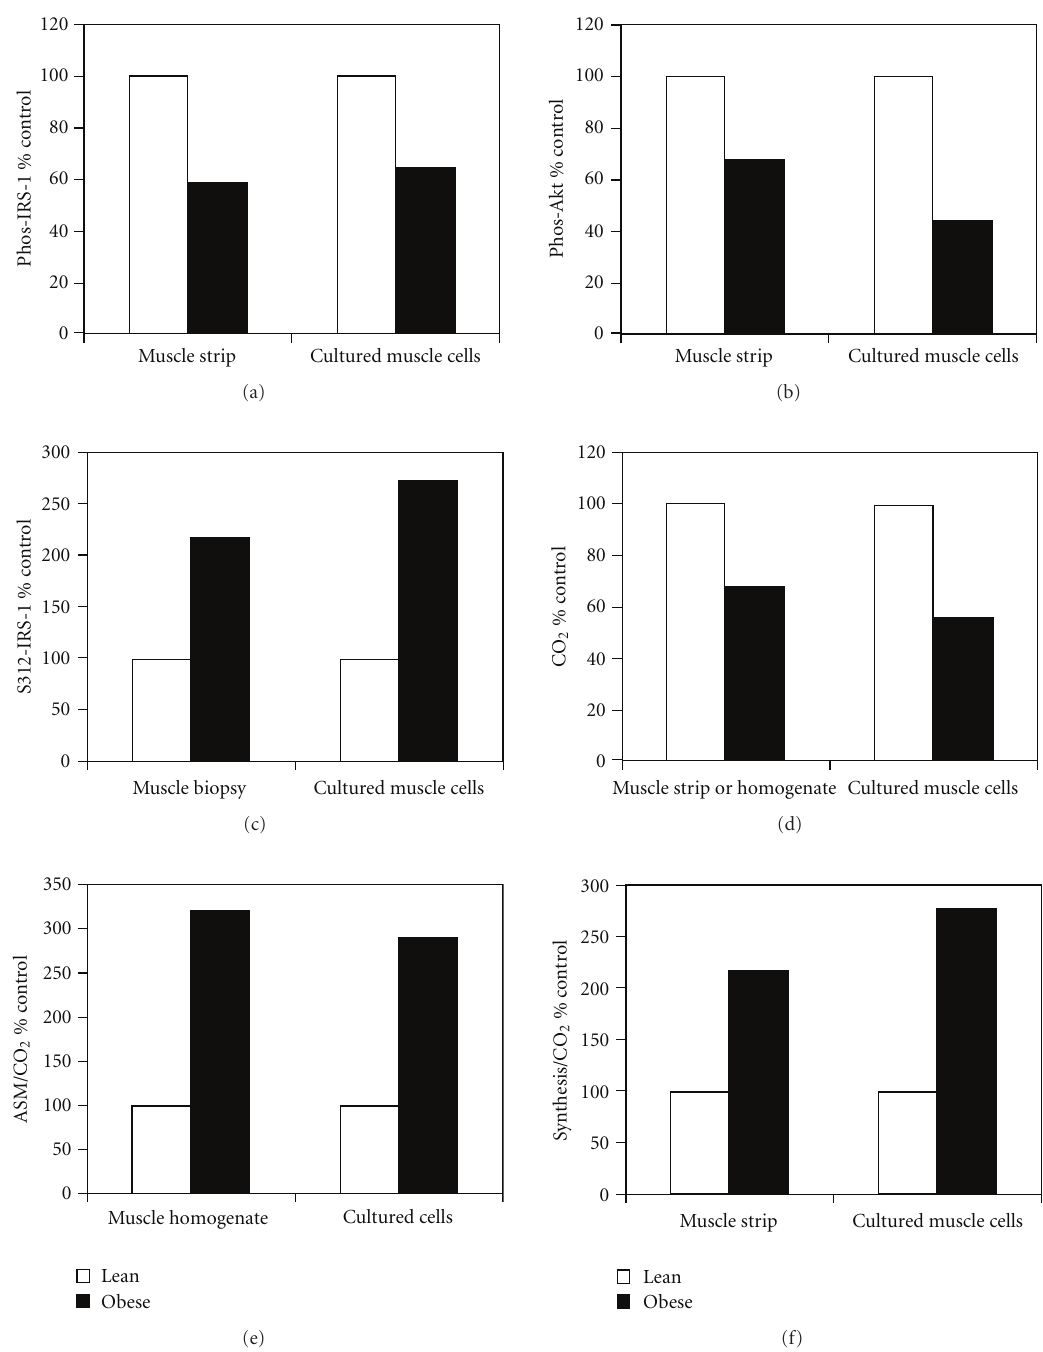
Figure 1: Comparison of insulin signal transduction and fatty acid oxidation in intact skeletal muscle and human skeletal muscle cells raised in culture (HSkMC) from lean and severely obese donors. Data in the graphs were calculated from mean values in the cited papers and nonobese control values used as 100%. (a) Insulin-stimulated tyrosine phosphorylation of IRS-1 (Phos-IRS-1) [14, 43, 44]. (b) Insulin-stimulated Akt phosporylation (Phos-Akt) [15, 43, 44]. (c) IRS-1 serine 312 phosphorylation (S312-IRS-1) [20, 43, 44]. (d) Complete fatty acid oxidation as determined from labeled CO 2 production from 14 C labeled palmitate (CO 2 ) [25, 27, 43, 45]. (e) Incomplete fatty acid oxidation from calculating the 14 C from labeled palmitate remaining in the acid soluble metabolite fraction divided by labeled CO 2 production (ASM/CO 2 ) [27, 43, 45]. (f) Partitioning between lipid synthesis and fatty acid oxidation (synthesis/CO 2 ) [25, 30, 43,